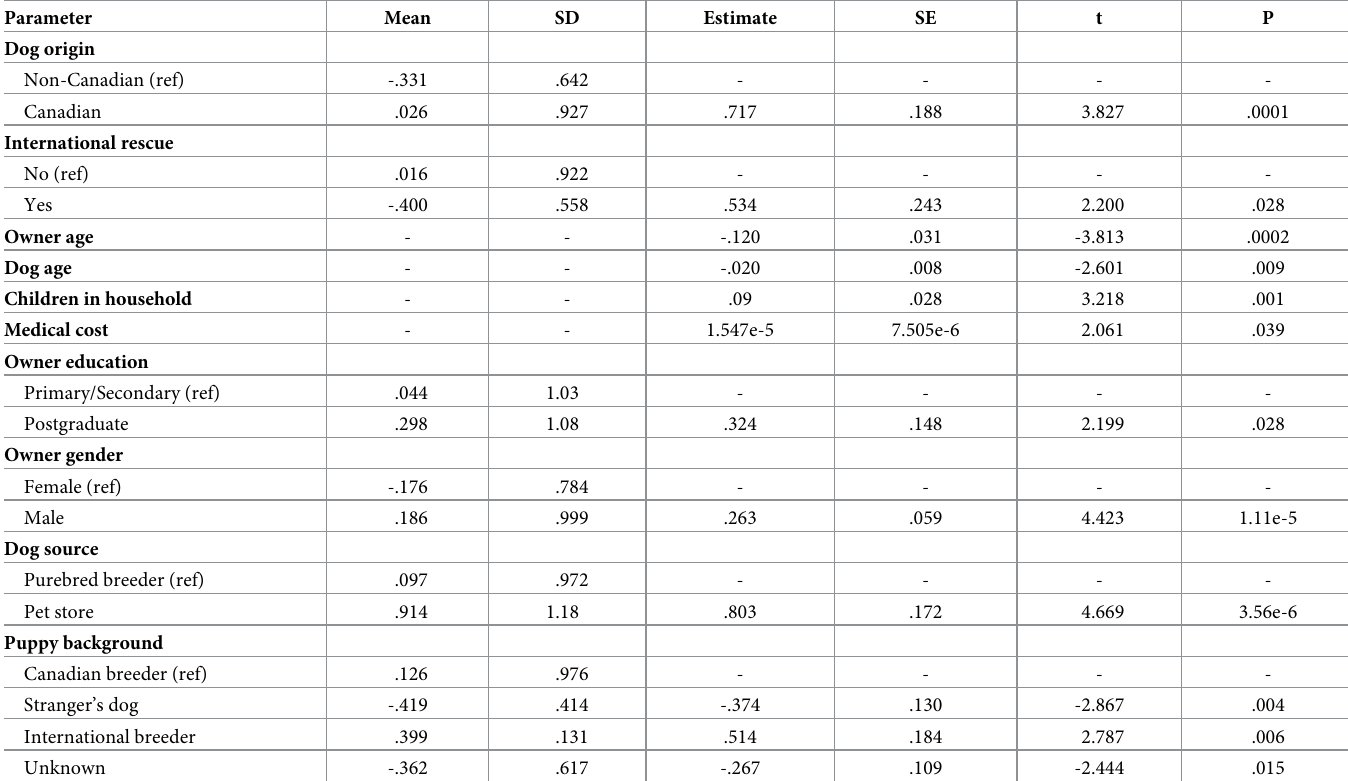
Table 10. Statistically significant interactions of owner and dog parameters on training methods Factor 1 “Harsh